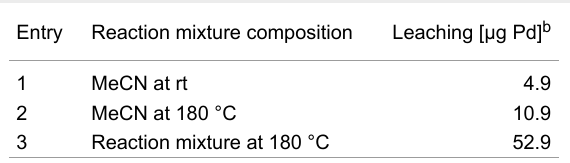
Table 2: Leaching of Pd from a “palladated” steel coil for the Mizoroki–Heck coupling of aryl iodide 12 with n -butyl acrylate ( 13 ) (Scheme 4).